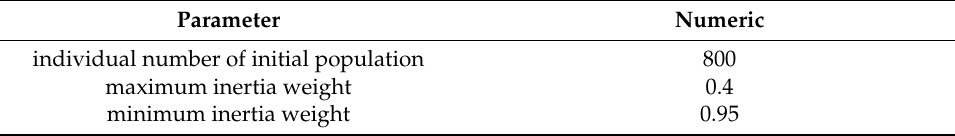
Table 2. Parameters of the MOPSO optimization